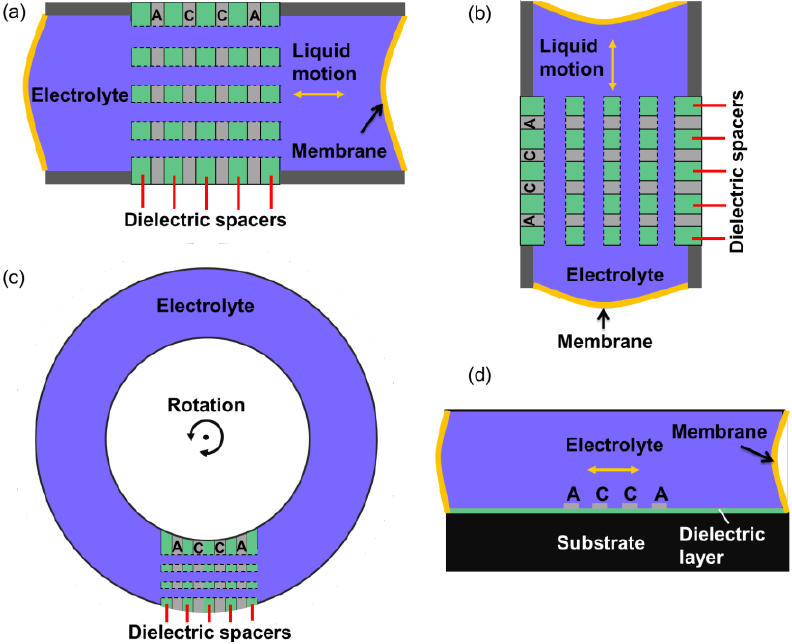
Figure 4. Schematic of different type of MET motion sensor.